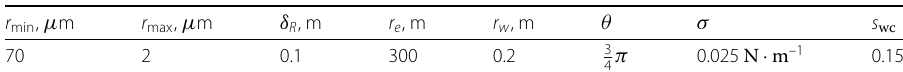
Table 1 Parameter